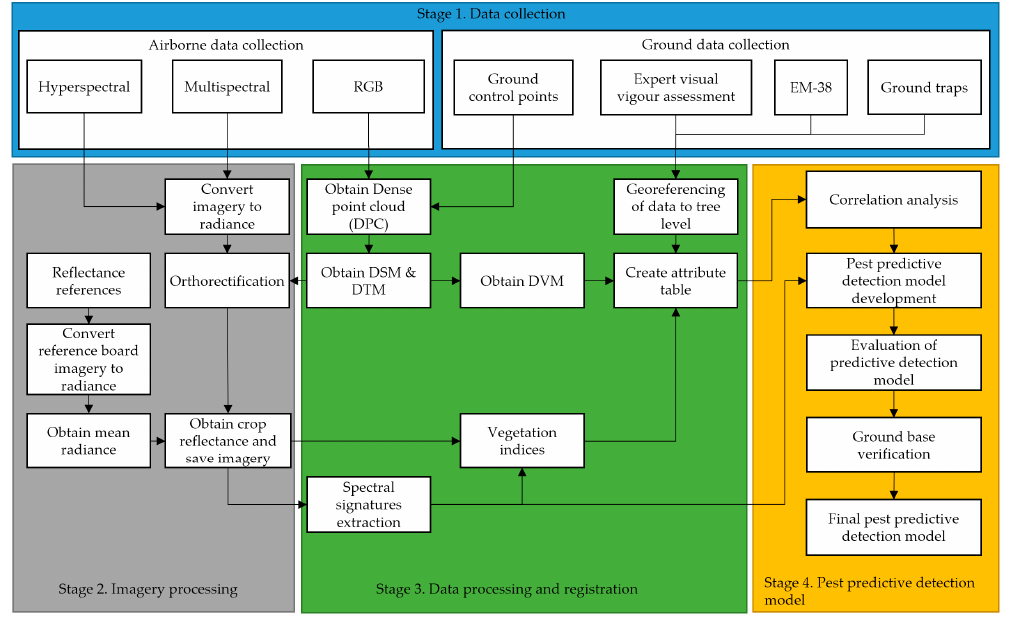
Figure 1. Predictive detection model workflow.